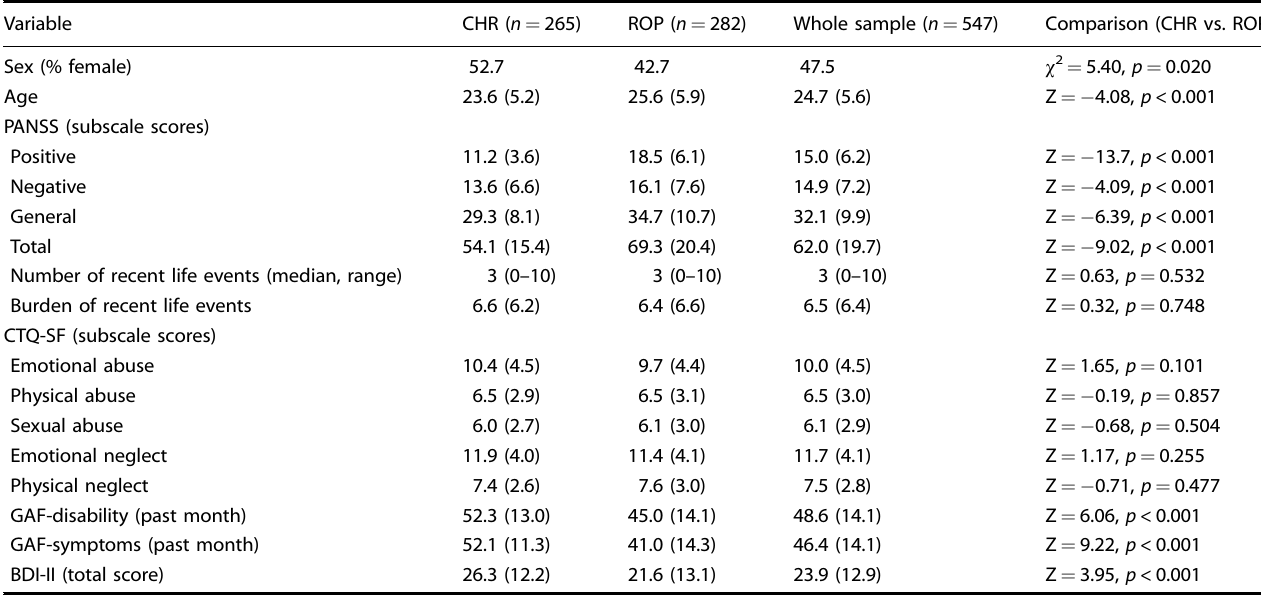
Table 1. Demographic and clinical characteristics of the sample at